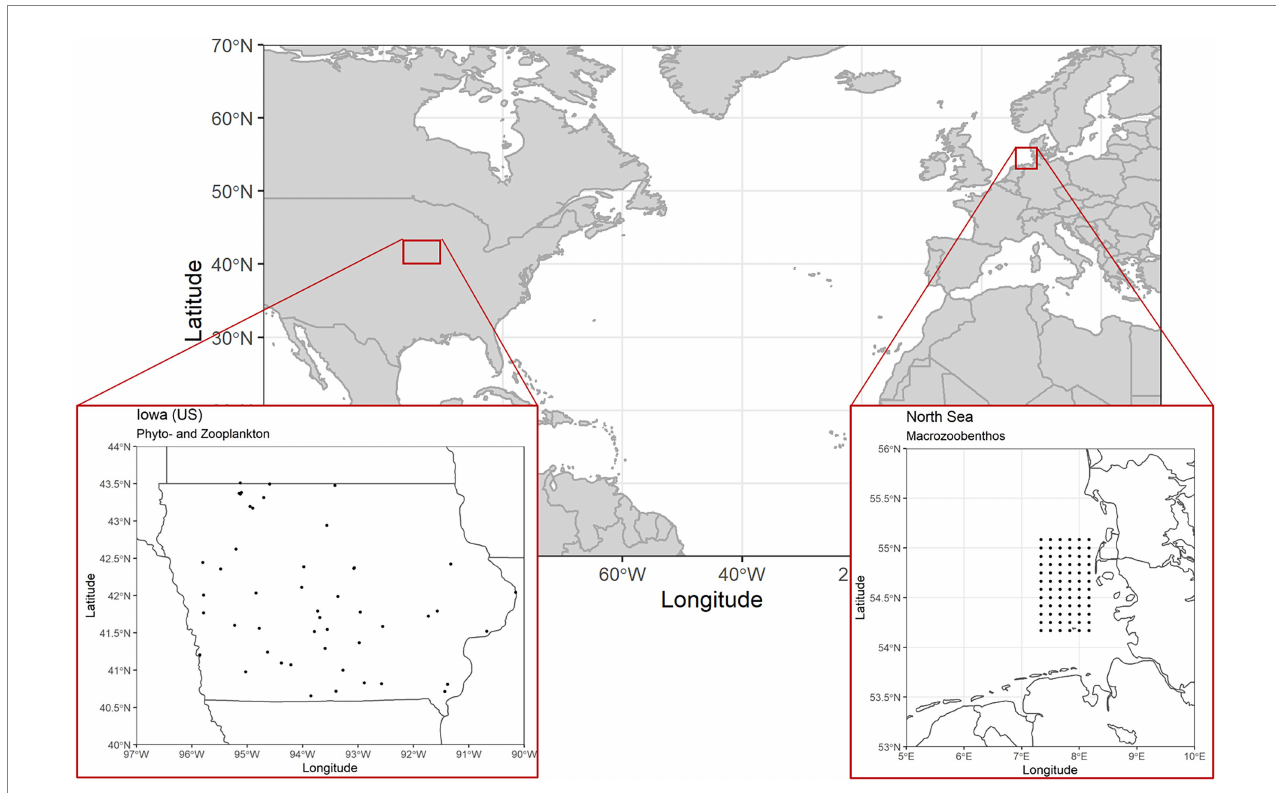
FIGURE 2 Map containing position of study area and location of single sampling sites for the three monitoring data sets. The sampling locations for phytoplankton and zooplankton samples coincide as they were recorded during sampling occasions of the same sampling campaign. The single sampling locations depict 49 lakes in Iowa (United States). The macrozoobenthos samples were obtained from a monitoring program covering a regular grid of 79 sampling locations off the coast of Northern Germany (North